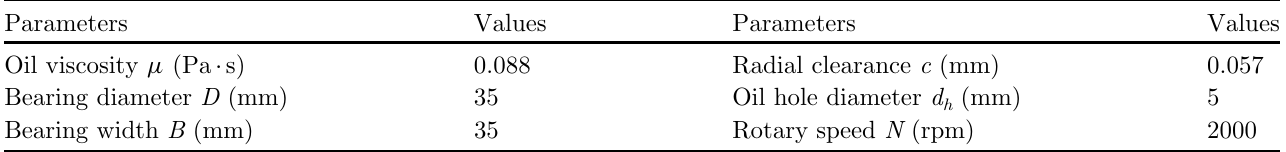
Table 1. Detailed parameters of a journal bearing.